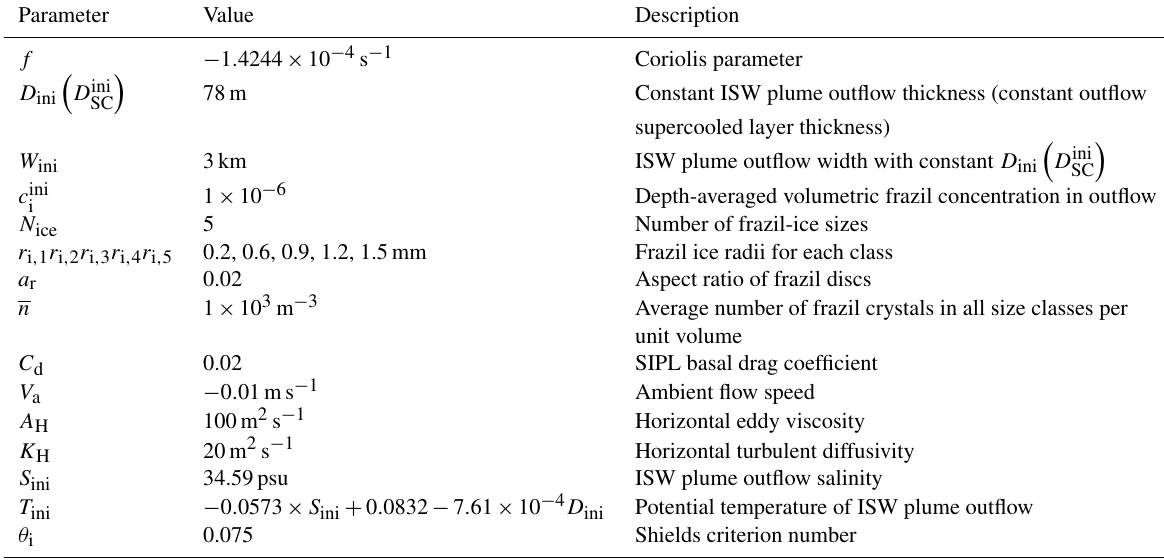
Table 1. List of parameters used in standard model run. Parameter